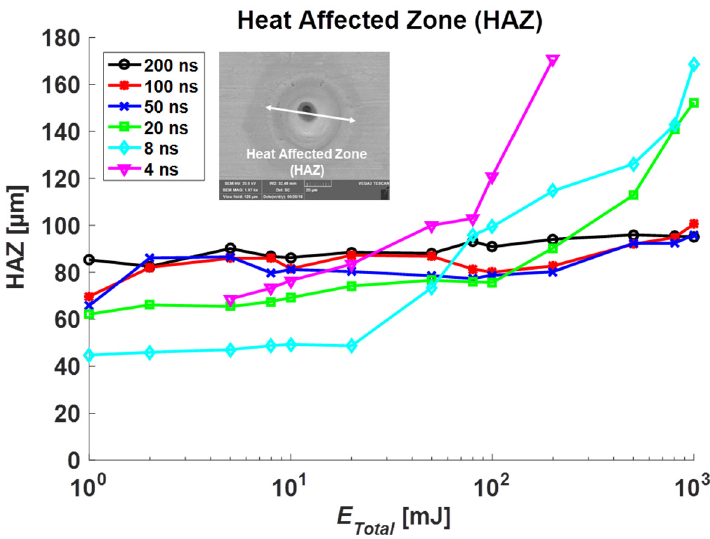
Figure 4 . Measurement results in the Heat-Affected Zone (HAZ) for Au-coated specimens.